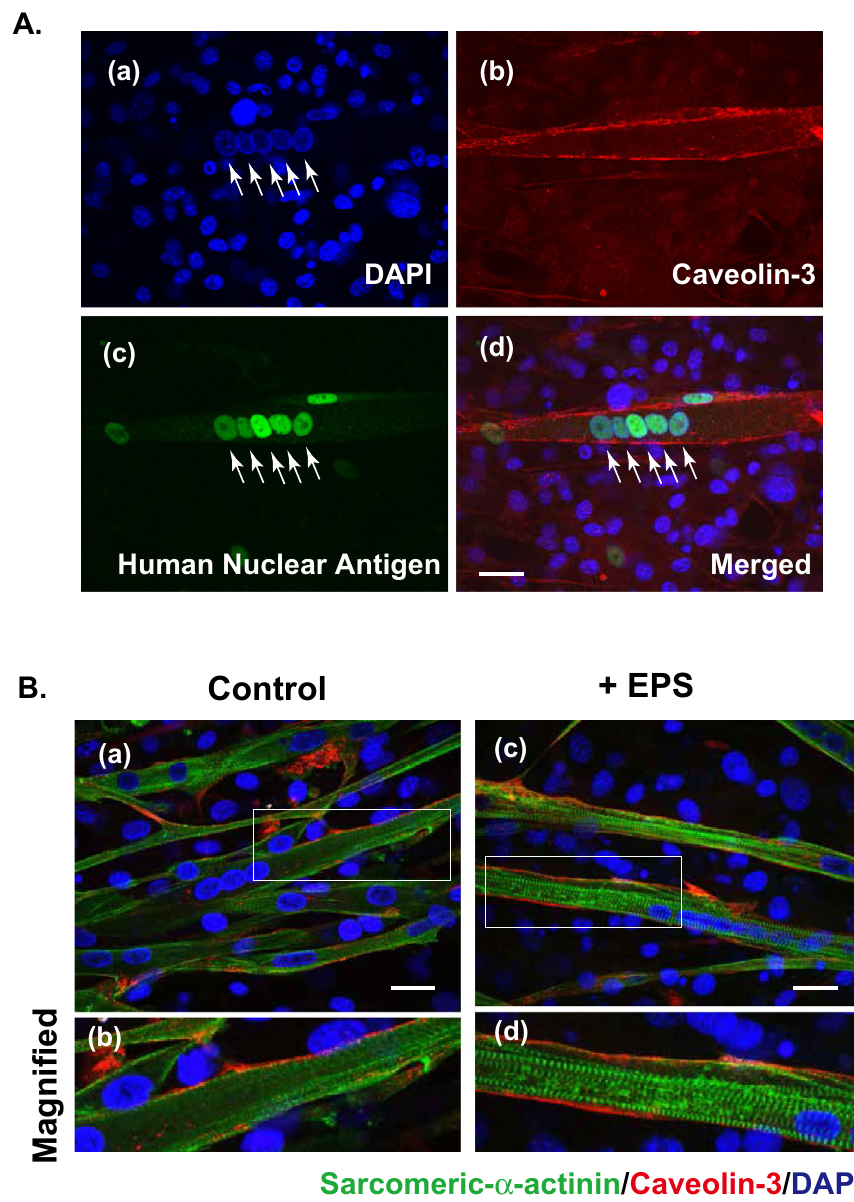
Figure 2. Sarcomere formation in contracting human myotubes on mouse fibroblast feeders. ( A ) After 7–8 days of differentiation, the differentiated human myotubes (derived from HSMM) on the feeder layers of mouse 3T3L1 fibroblasts were fixed and then observed for myotubular formation by using anti-human nuclear antigen (anti-HNA) and anti-Caveolin 3 antibodies, as described in the “Methods” section. DAPI was used for nuclear staining. Scale bar = 25 μm. Three independent experiments were performed, and representative images are presented. ( B ) The differentiated human myotubes on the mouse fibroblast feeders were subjected to either no ( panels a and b ) EPS or ( panels c and d ) EPS treatment (1 Hz frequency, 4-ms duration, 20 V/25 mm for a total 24 h of with intermittent intervals) and then fixed for evaluating sarcomere formation status by using anti- sarcomeric-α-actinin ( green ) and anti-Caveolin 3 ( red ) antibodies. DAPI was used for nuclear staining ( blue ). Scale bar = 25 μm. Magnified images ( panels b and d ) of the white boxes in panels a and c , respectively, are also presented. Three independent experiments were performed and representative images are